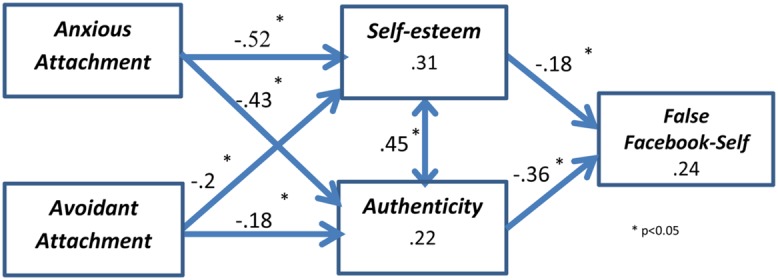
Structural model.